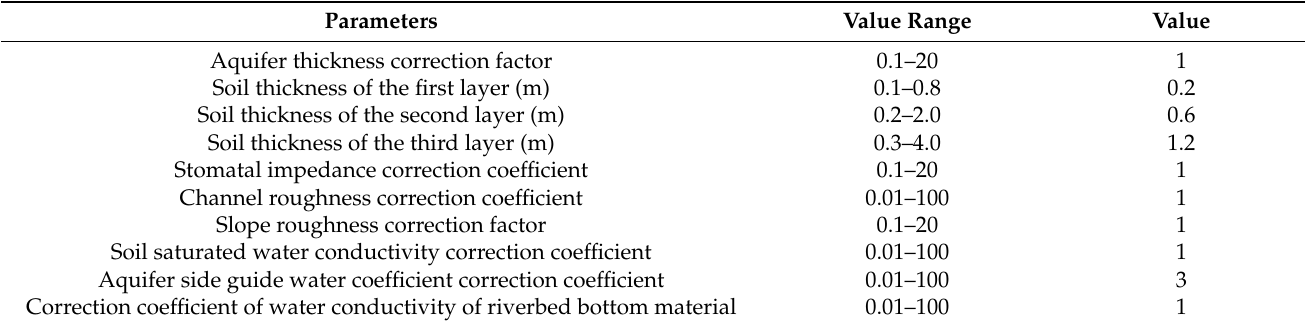
Table 3. Simulation effect evaluation of cross ‐ section discharge in Xiaoqing River Basin.